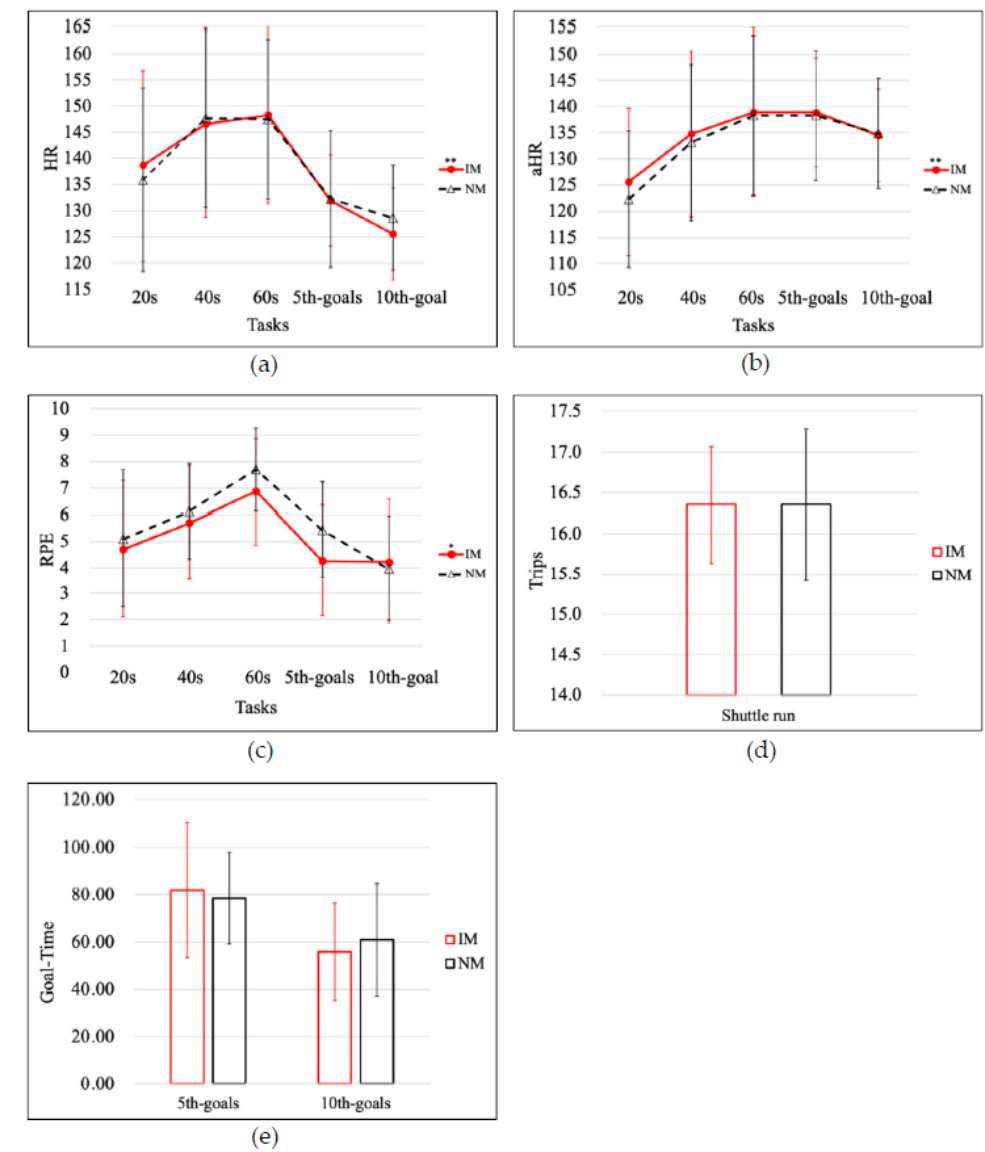
Figure 8. ( a ) The heart rate response, ( b ) the average heart rates (aHR) response and ( c ) the RPE response during the tasks with IM (red) and NM (black). ( d ) The shuttle run task performance and ( e ) the shooting task performance. * p < 0.05; ** p < 0.01.